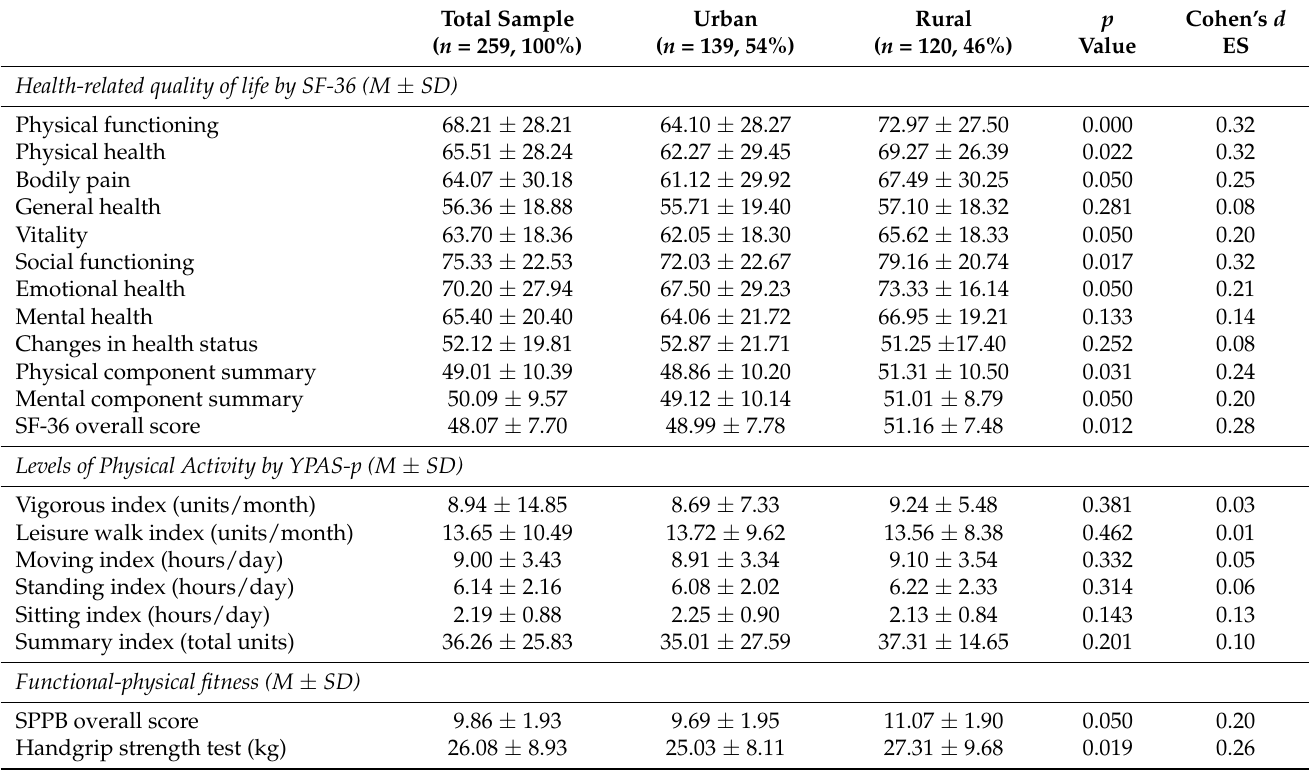
Table 2. Characterization of health-related quality of life physical activity levels and physical- functional fitness status according to the living place of the participants.